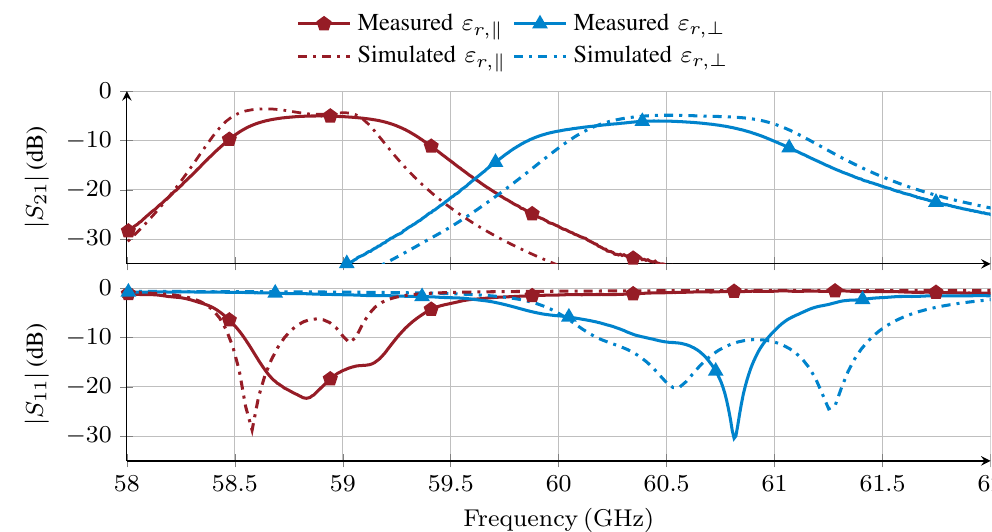
Figure 56. Measured and simulated S-parameters for orthogonal and parallel LC orientation of the presented tunable bandpass